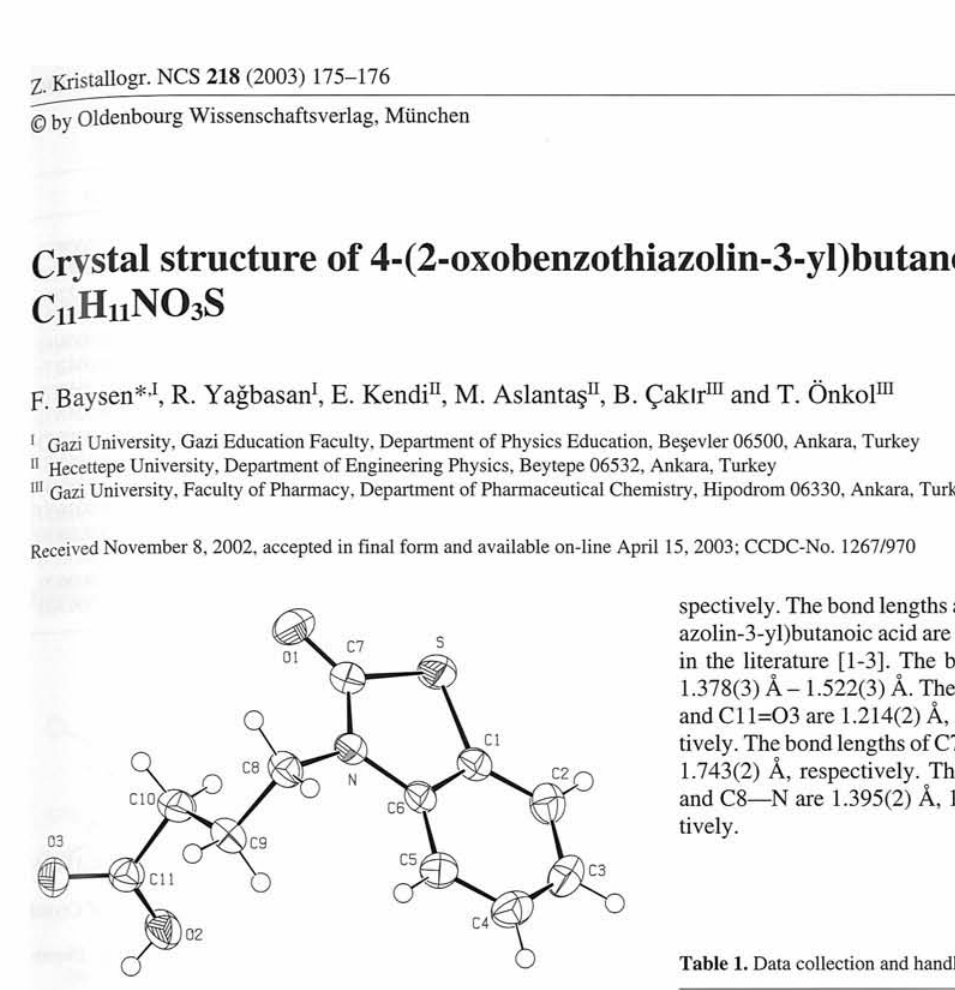
Table 2. Atomic coordinates and displacement parameters (in Â 2